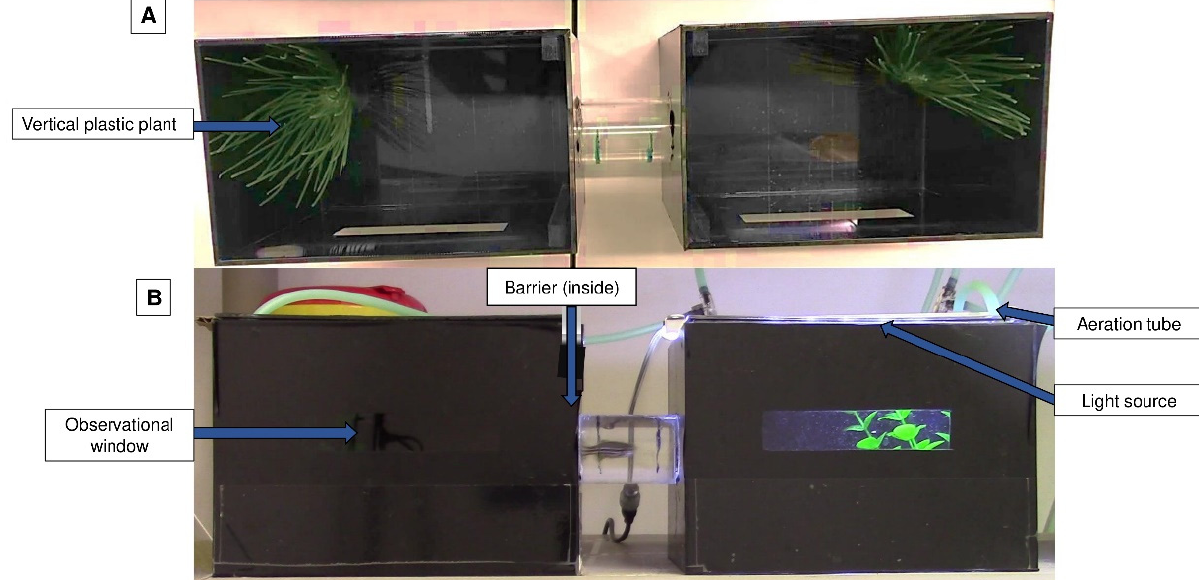
Figure 1. Conditioned place aversion apparatus view from above ( A ) and from the side ( B ). Tanks were individually lighted and only one tank had the lights on at a certain time. A transparent tube linked the tanks for the animals to pass; a plant and aeration were provided on each side to increase animal welfare.